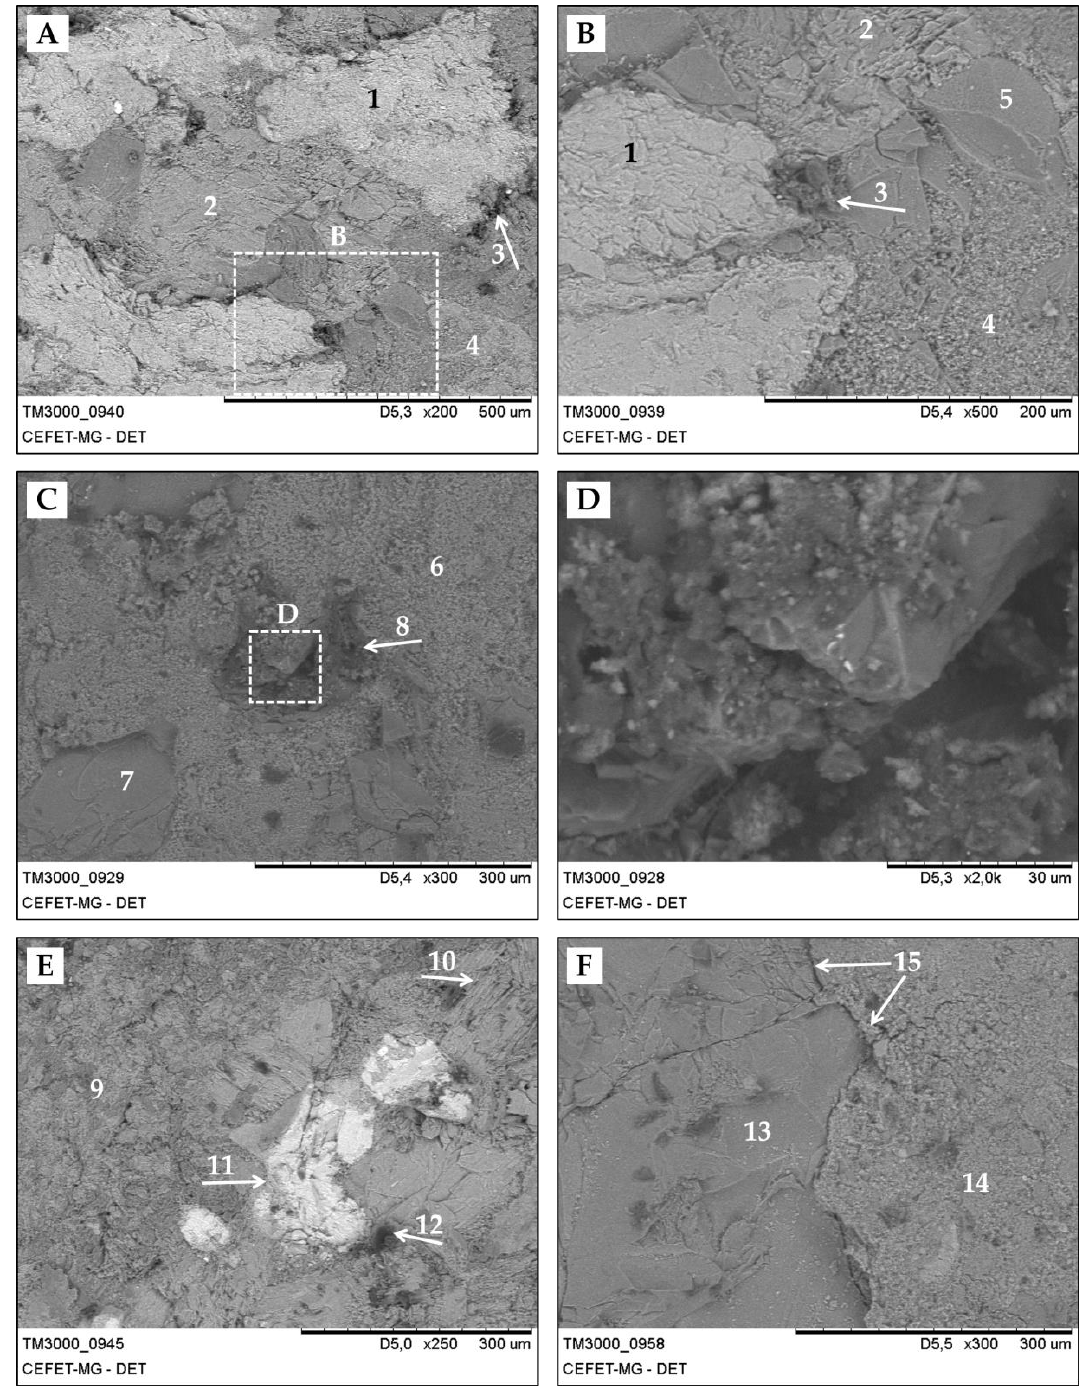
Figure 20. SEM images of alkali-activated binder concrete ( a ) AABC-06 - 200X; ( b ) AABC-06 - 500X; ( c ) AABC-06 - 300X; ( d ) AABC-06 - 2000X; ( e ) AABC-06 - 250X; ( f ) AABC-06 -